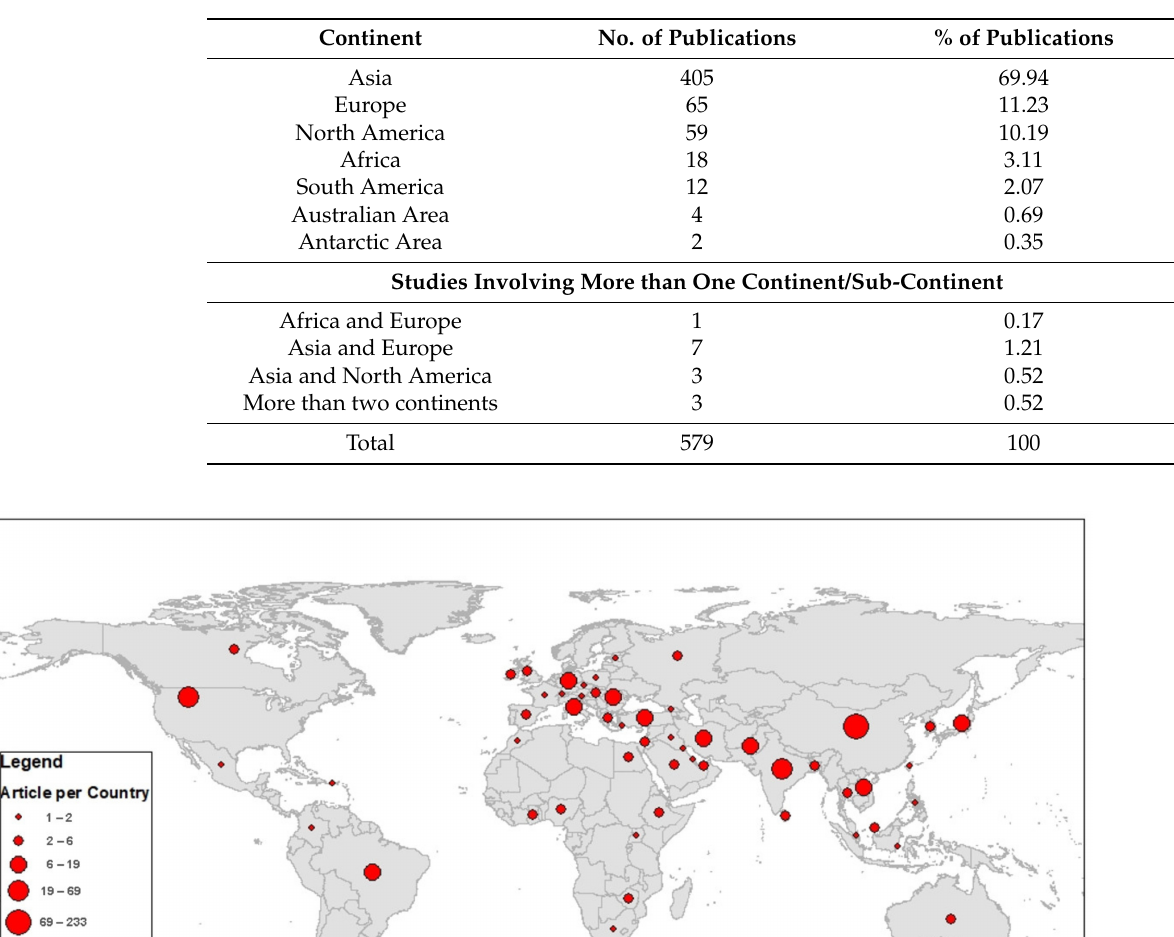
Table 2. Published papers by continent/sub-continent.